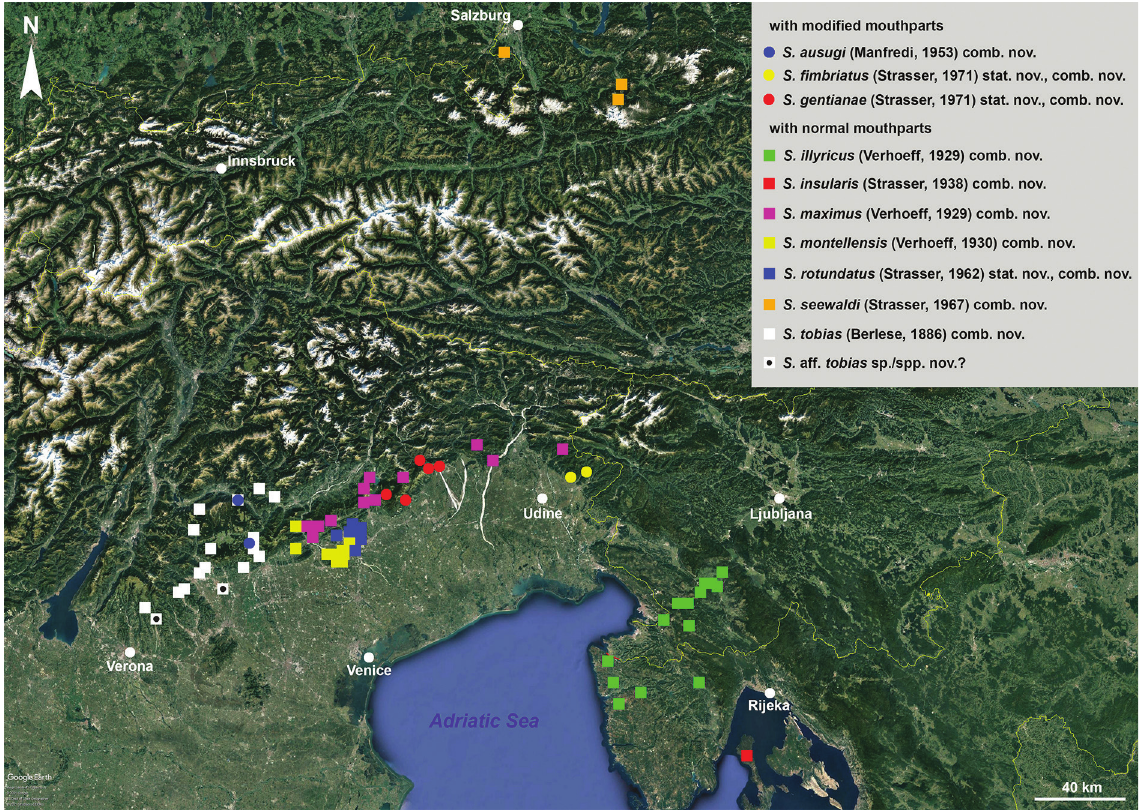
Fig. 13. General distribution of the species of the genus Stygiiulus stat.